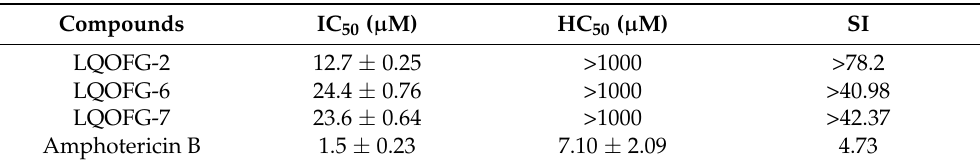
Table 1. The half-maximal inhibitory concentration of the growth of L. infantum promastigotes (IC 50 ) treated with guanidine-derived compounds and